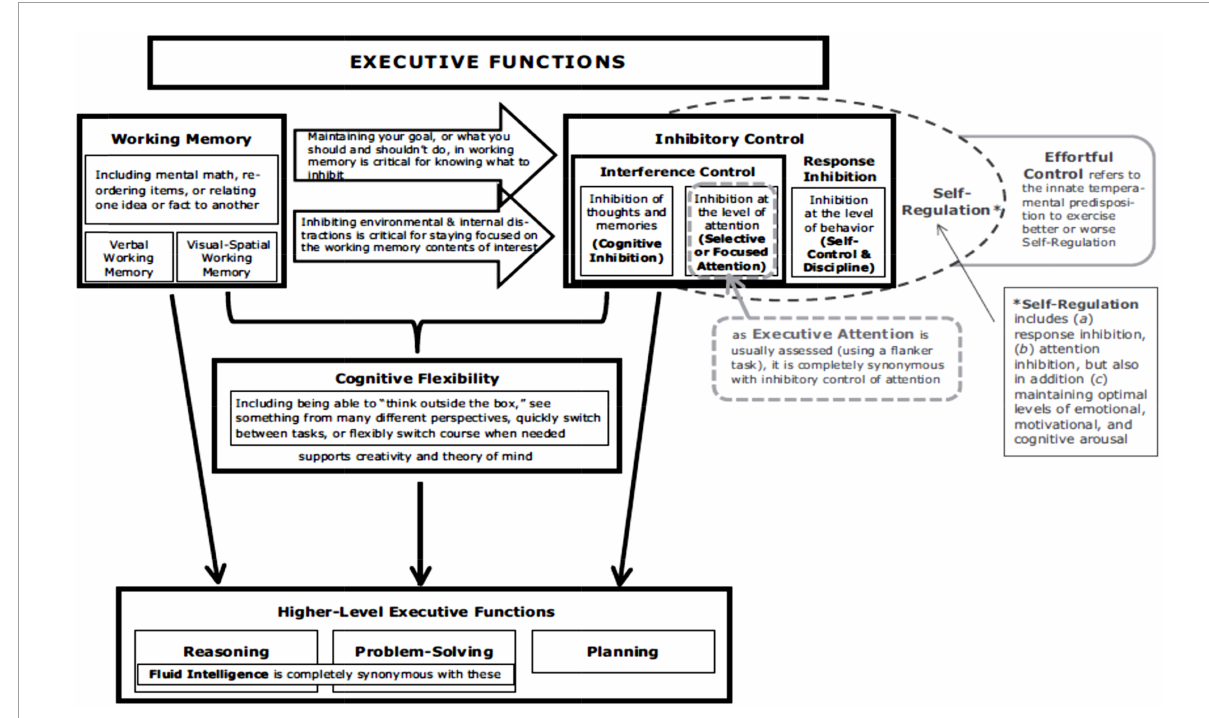
FIGURE2 Structure of Executive Processes Based on Diamond’s Proposal Diamond (2013). Reproduced with permission from the Annual Review of Psychology, Volume 64 © 2013 by Annual Reviews,